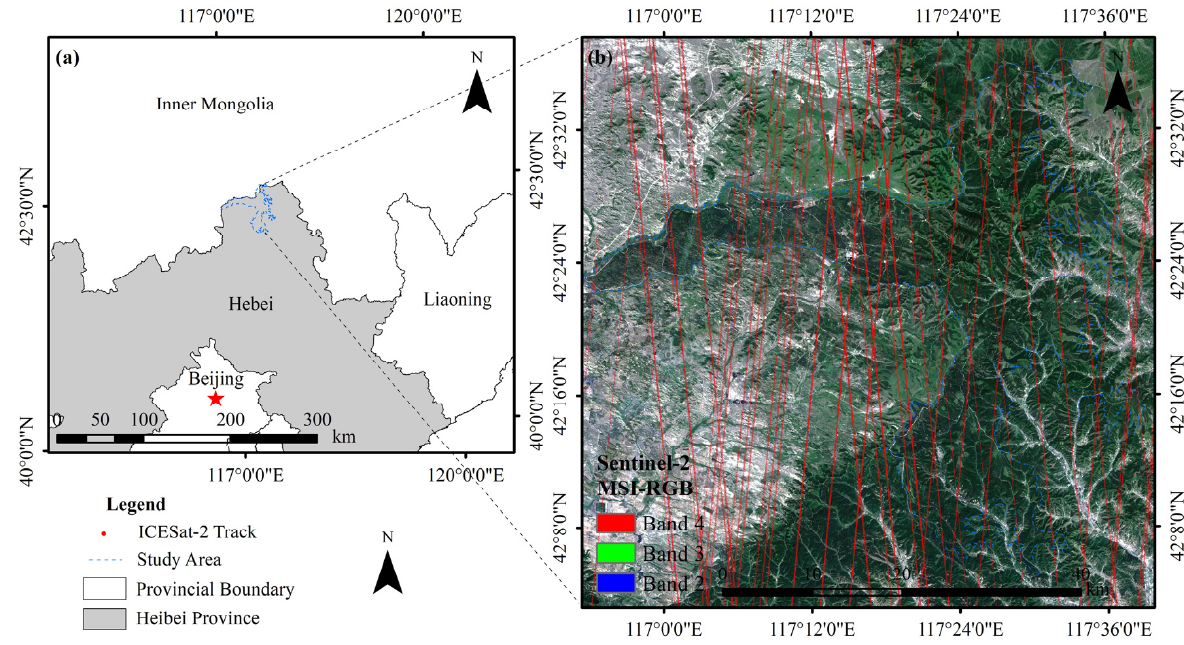
Figure 1. ( a ) Locations of the study area; ( b ) synthetic color image from Sentinel-2 covering Saihanba forest farm, with ICESat- 2.